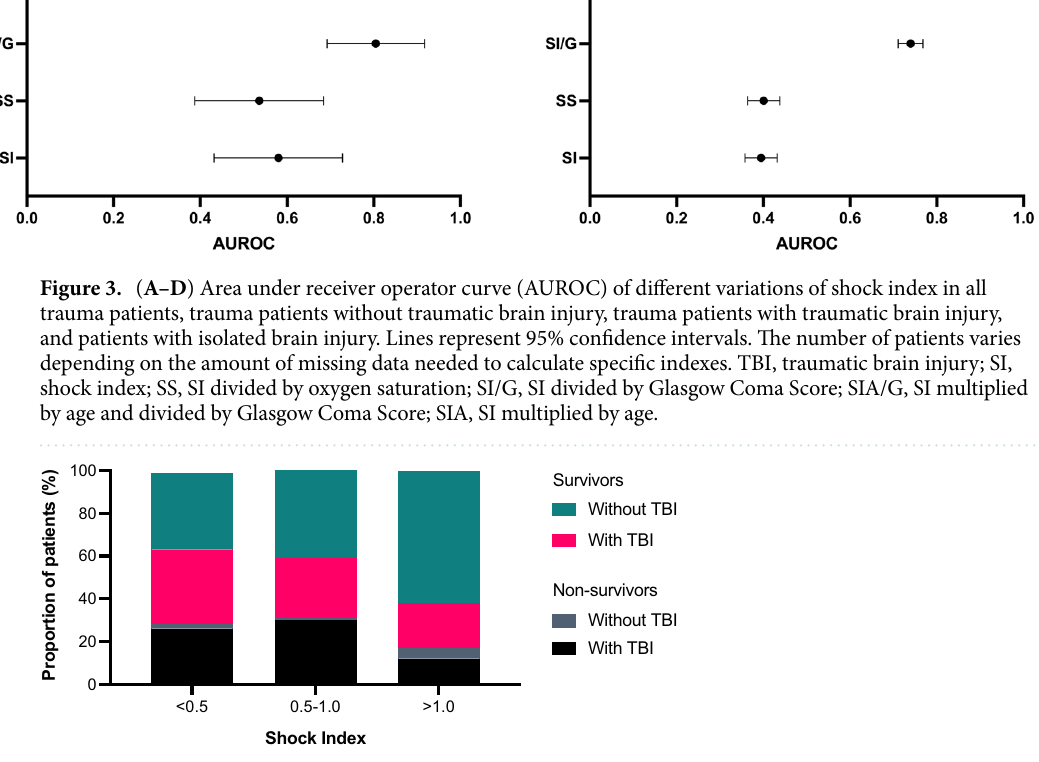
Figure 4. Proportions of survivors and non-survivors with and without traumatic brain injury (TBI) in low (< 0.5), normal (0.5–1.0), and high (> 1.0) shock index